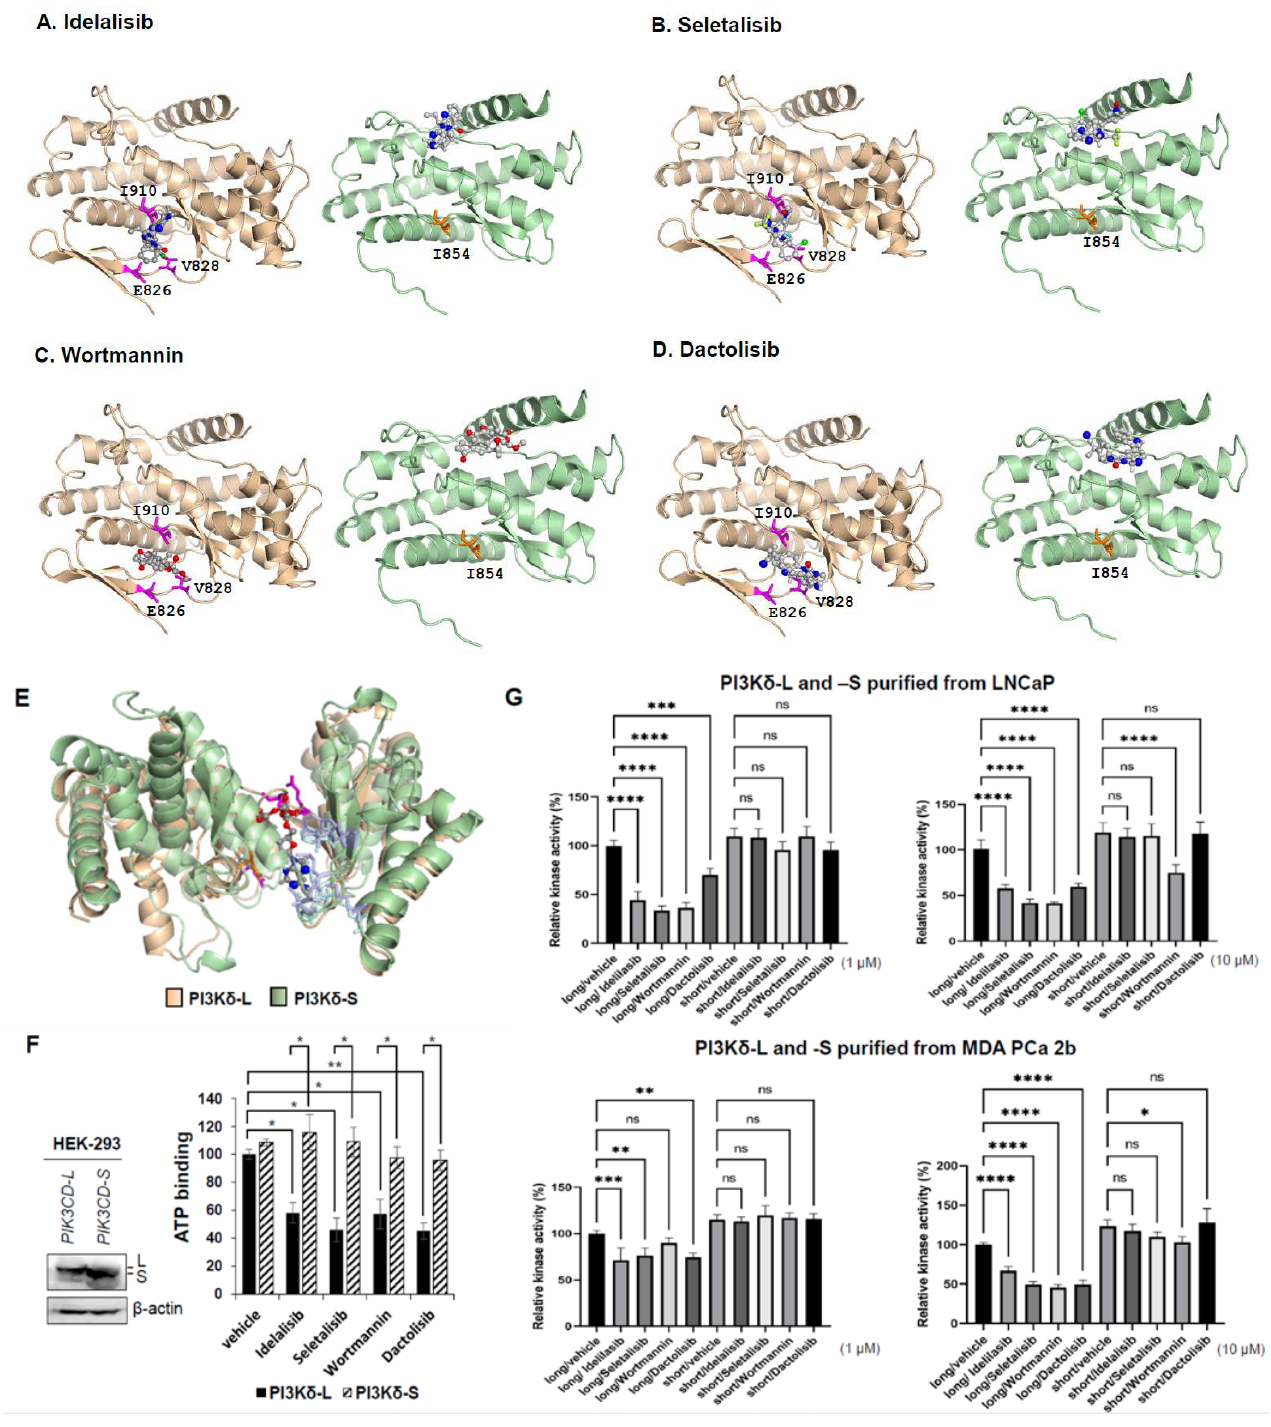
Figure 5. Molecular modeling of interactions between small-molecule inhibitors and PI3K δ -L or PI3Kδ -S splice isoform . Molecular docking modeling using AutoDock Vina demonstrates the pre- dicted physical interactions between PI3Kδ - L and PI3Kδ -S with ( A ) Idelalisib, ( B ) Seletalisib, ( C ) Wortmannin, and ( D ) Dactolisib. ( E ) Molecular modeling for ATP (ball-and-stick chemical) binding with PI3Kδ - L (brown) and PI3Kδ -S (green). ( F ) ATP- binding assays with PI3Kδ - L and PI3Kδ -S in competition with the four PI3K inhibitors (right panel). Western blot analysis (left panel) confirmed the comparable amounts of PI3K δ - L and PI3Kδ -S were purified from PIK3CD-L- and PIK3CD-S- expressing HEK-293 cells, for the ATP-competitive assays. Data values were represented as mean ± SD from 3–4 independent experiments. * , ** p -values (<0.05 and <0.01) were determined based on one-way ANOVA with Tukey’s post hoc test. ( G ) Cell- free PI3 kinase assays of purified PI3Kδ -L and PI3Kδ -S complexes incubated with four small-molecule inhibitors at 1 and 10 μM. The purified PI3Kδ - L and PI3Kδ -S complexes were from LNCaP and MDA PCa 2b cells transfected with pcDNA3.1- PIK3CD-L -V5-His and pcDNA3.1- PIK3CD-S -V5-His plasmids . ** , *** , **** p- values (<0.01, <0.001, and <0.0001) were determined based on one-way ANOVA with Tukey’s post hoc test. ns: not significant. Data values represent mean ± SEM from 3–4 independent experiments with dupli- cated repeats. 3.7. Competitive Drug/ATP-Binding Assays and Kinase Activity Assays Confirm a Reduced Binding Affinity between PI3Kδ -S and Drugs The PI3 kinase activity is determined by the efficiency of ATP binding to PI3K. A previous study has revealed that ATP docks at K708, M752, D753, S754, W760, I777, and D911 in the ATP- binding pocket of the PI3Kδ catalytic domain [31]. In the presence of an ATP-competitive inhibitor (Idelalisib, Seletalisib, Wortmannin, or Dactolisib), ATP fails to efficiently dock at the binding sites in the catalytic domain, thereby hindering the PI3Kδ activity. We hypothesized that the differential drug sensitivities in PI3Kδ - L vs. PI3Kδ -S is mainly due to their differential ATP-binding affinities in the presence of the PI3K inhibi- tors. The molecular modeling by superimposing PI3Kδ - S with PI3Kδ -L and ATP docking demonstrated that (1) the 3D structures of PI3Kδ - L and PI3Kδ -S are nearly identical, ex- cept the hinge and hydrophobic regions are missing in P I3Kδ -S (Figure 5E and Supple- mentary Figure S2), and (2) the ATP- binding sites are reserved in both the PI3Kδ -L and PI3Kδ -S isoforms; however, the critical drug-binding residues E826 and V828 are missing in the PI3Kδ -S catalytic domain (Supplementary Figure S2). For further validating our